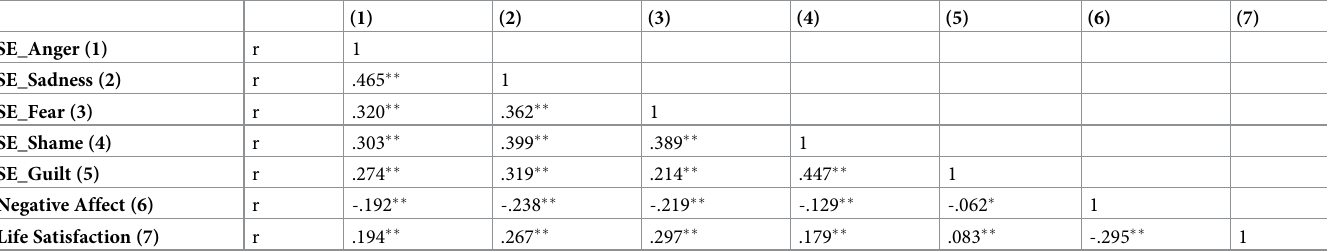
Table 4. Correlations among the five sub-scales of the MNESRES, negative affect and life